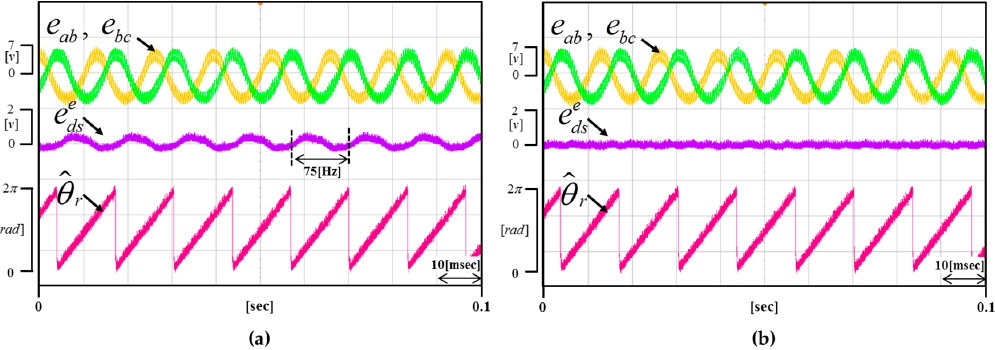
Figure 15. ( a ) Waveform of the not applied proposed method ( b ) Waveform of the applied proposed method (Operating condition: ω r = 3000 r/min). Figure 16 shows the real-time dynamic characteristics of the DC offset error component by applying 0.6 V to the portion (a), 1.2 V to the portion (b), and 0.3 V to the portion (c). Figures 17–19 are enlargements of each portion in Figure 16 (a–c). Figure 17 shows that the time of compensation is 200 ms. Figure 18 shows that the time of compensation is 320 ms. Figure 19 shows that the time of compensation is 380 ms.